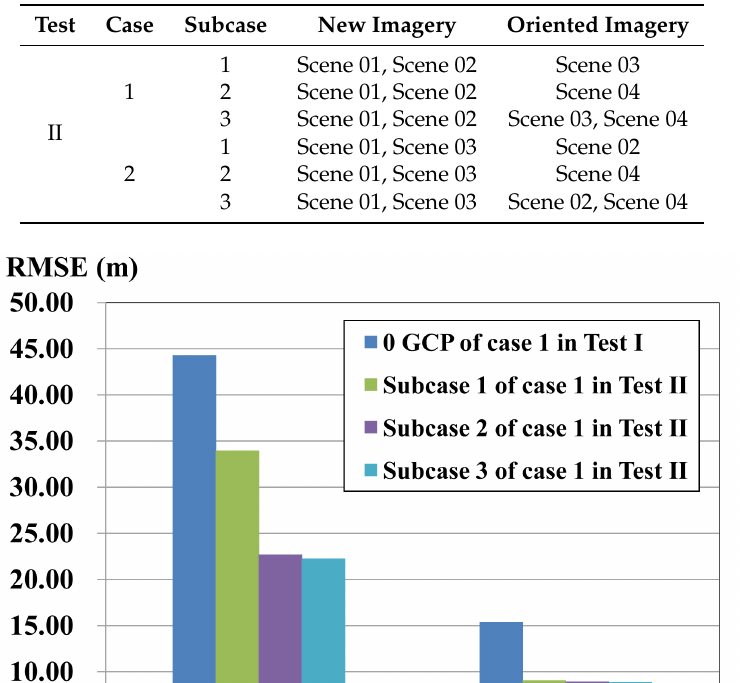
Table 5. SPOT-5 datasets for direct georeferencing with the oriented imagery.